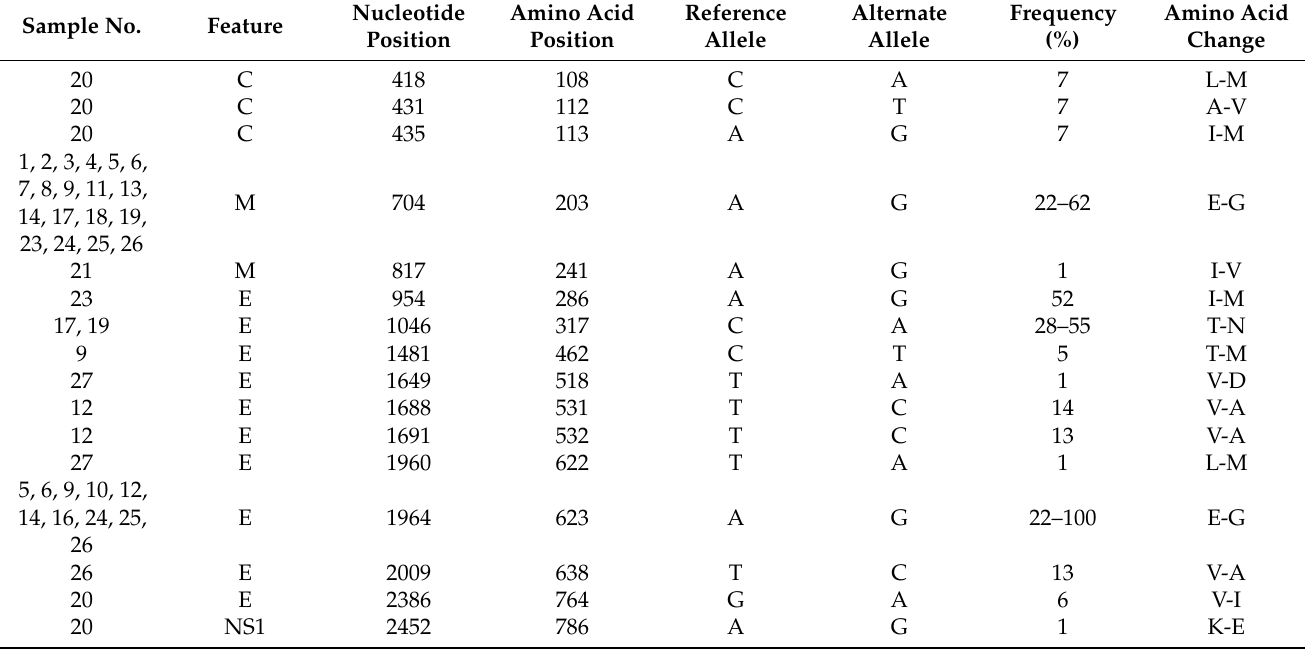
Figure 4. Phylogenetic tree based on whole-genome sequencing of 26 DENV-2 strains (indicated by asterisks, and red and blue colored fonts for each clade) isolated from the 2017 dengue outbreak in Nepal. The DENV-2 phylogenetic tree was reconstructed using the maximum likelihood method. The 20 reference strains used in the phylogenetic tree were obtained from Genbank and are named by country origin, strain name, year of isolation, and GenBank accession number. Table 2. Non synonymous variants ( ≥ 1%) alleles shared among the complete genome of DENV-2 isolates from 2017 outbreak,